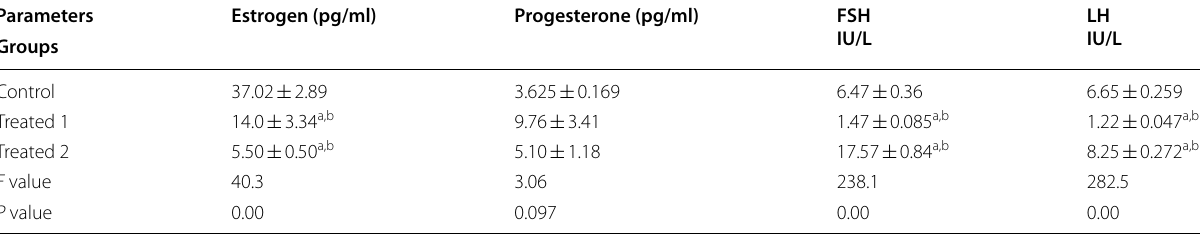
O NPs on female reproductive hormones 3 4